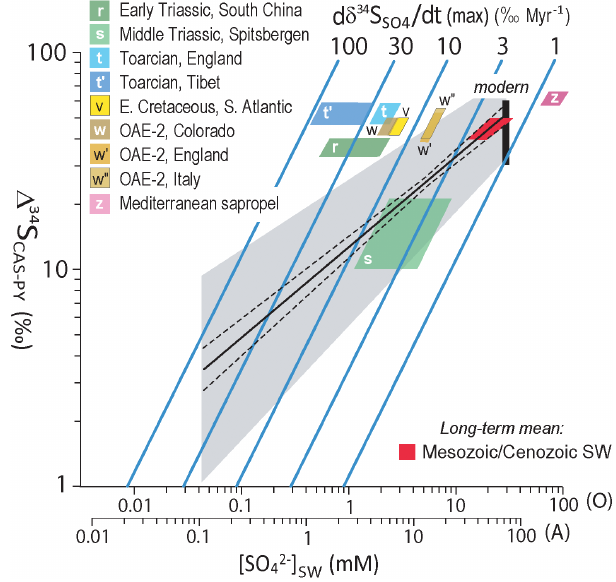
Figure 8. Analysis of seawater sulfate concentrations for eight Mesozoic–Cenozoic marine units. The parallelogram for each unit was generated using the rate method. The red field represents the long-term average (cid:49) 34 S CAS-PY for the Mesozoic–Cenozoic based on data in Wu et al. (2010). A summary of results and data sources is given in Table S4; other details as in Figs. 1–2.